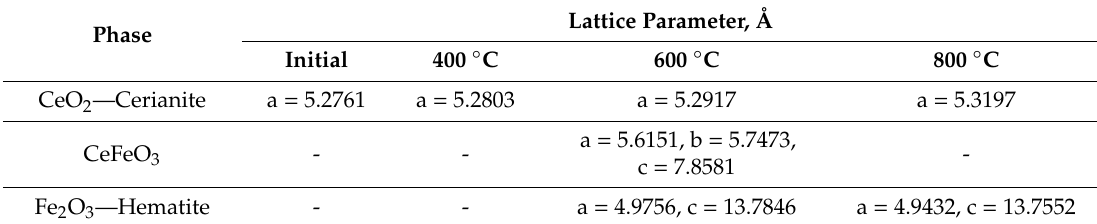
Table 3. Data on alterations in parameters of the crystal lattice.